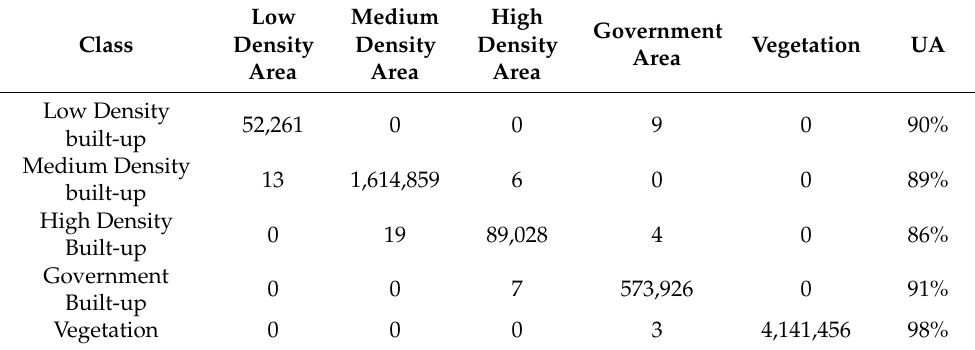
Table 6. Rapid Eye 2018 image classification confusion matrix